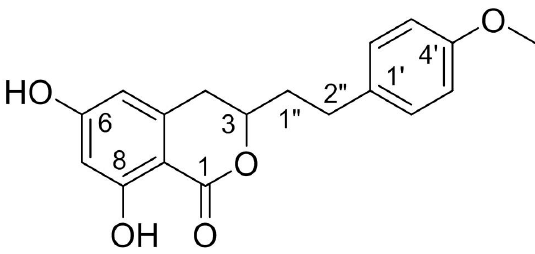
Figure 1. Chemical structure of AM.